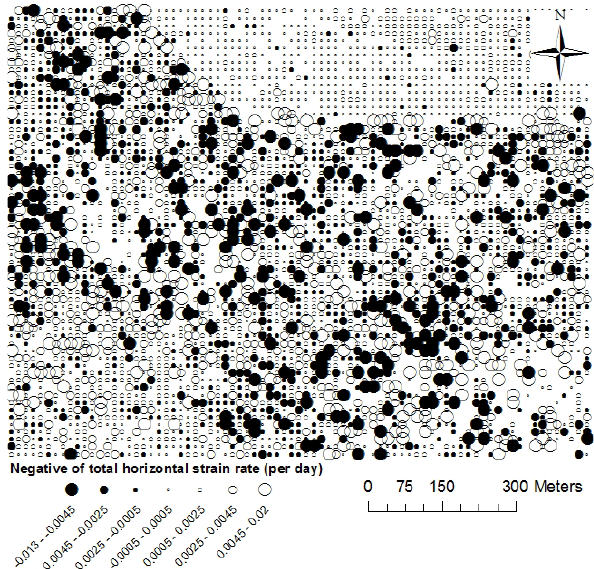
Figure 8. The negative sum of the horizontal strain rates (assumed to be equal to the vertical strain rate) of the Nigardsbreen